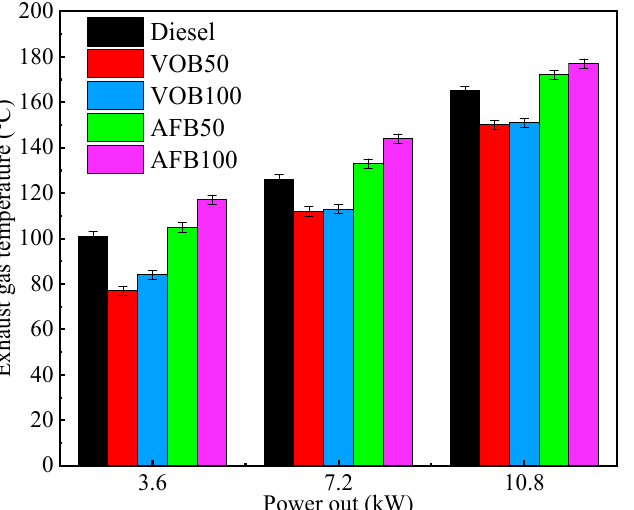
Figure 20. EGT comparison of AFB biodiesel and VOB biodiesel blends under different brake powers [214].